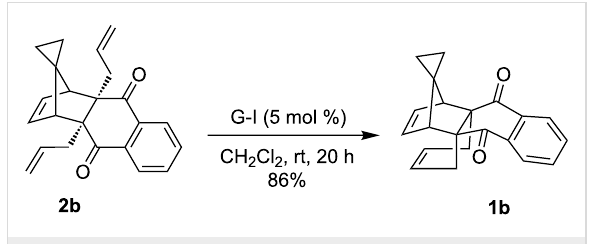
Scheme 5: RCM approach to the propellane derivative 1b .